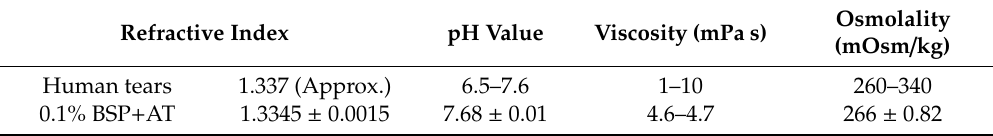
Table 1. Characteristics of human tears [30–32] and artificial tears.